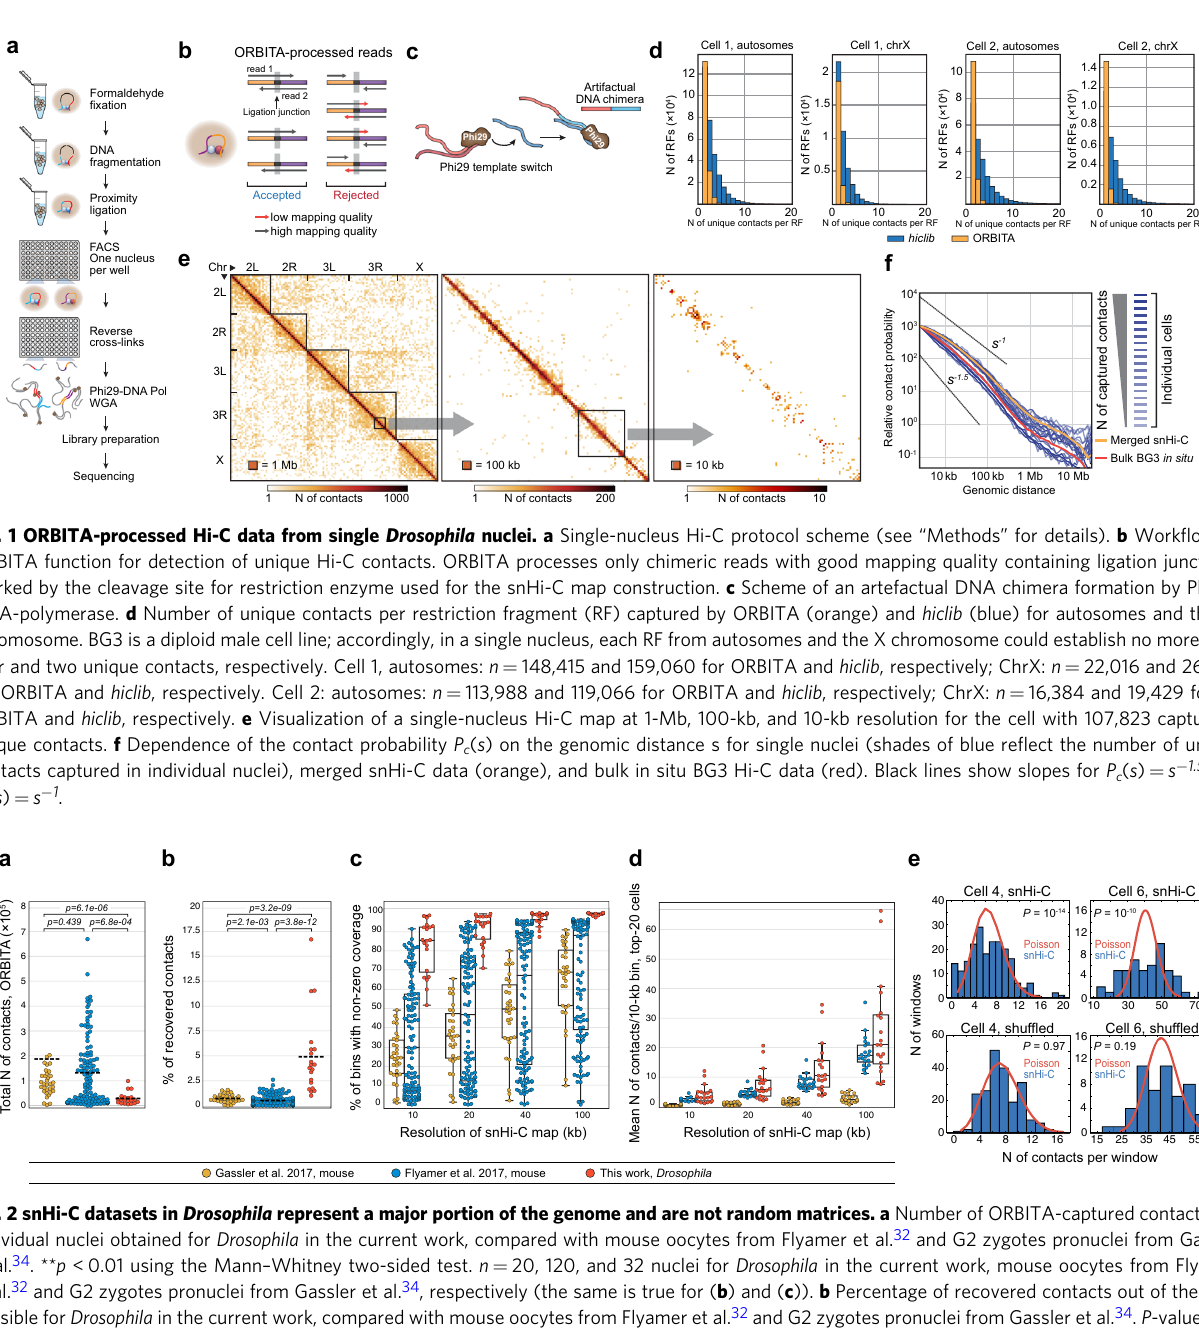
and corresponded to four contacts per 10-kb genomic bin (see “ Methods ” ); in the best cell, 17% of contacts were recovered